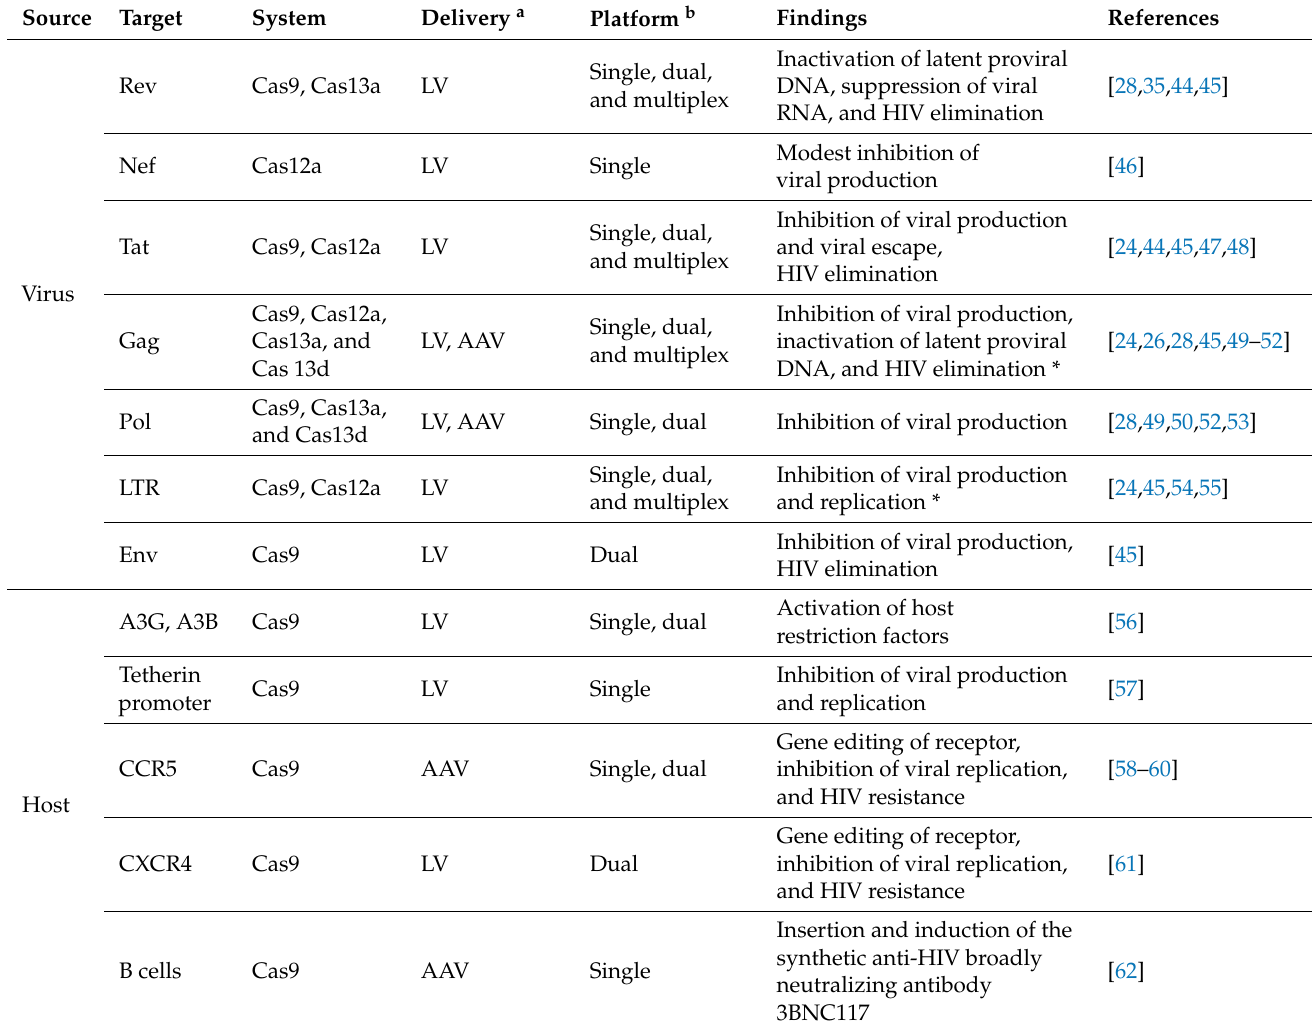
Table 1. Summary of CRISPR-Cas gene editing approaches against